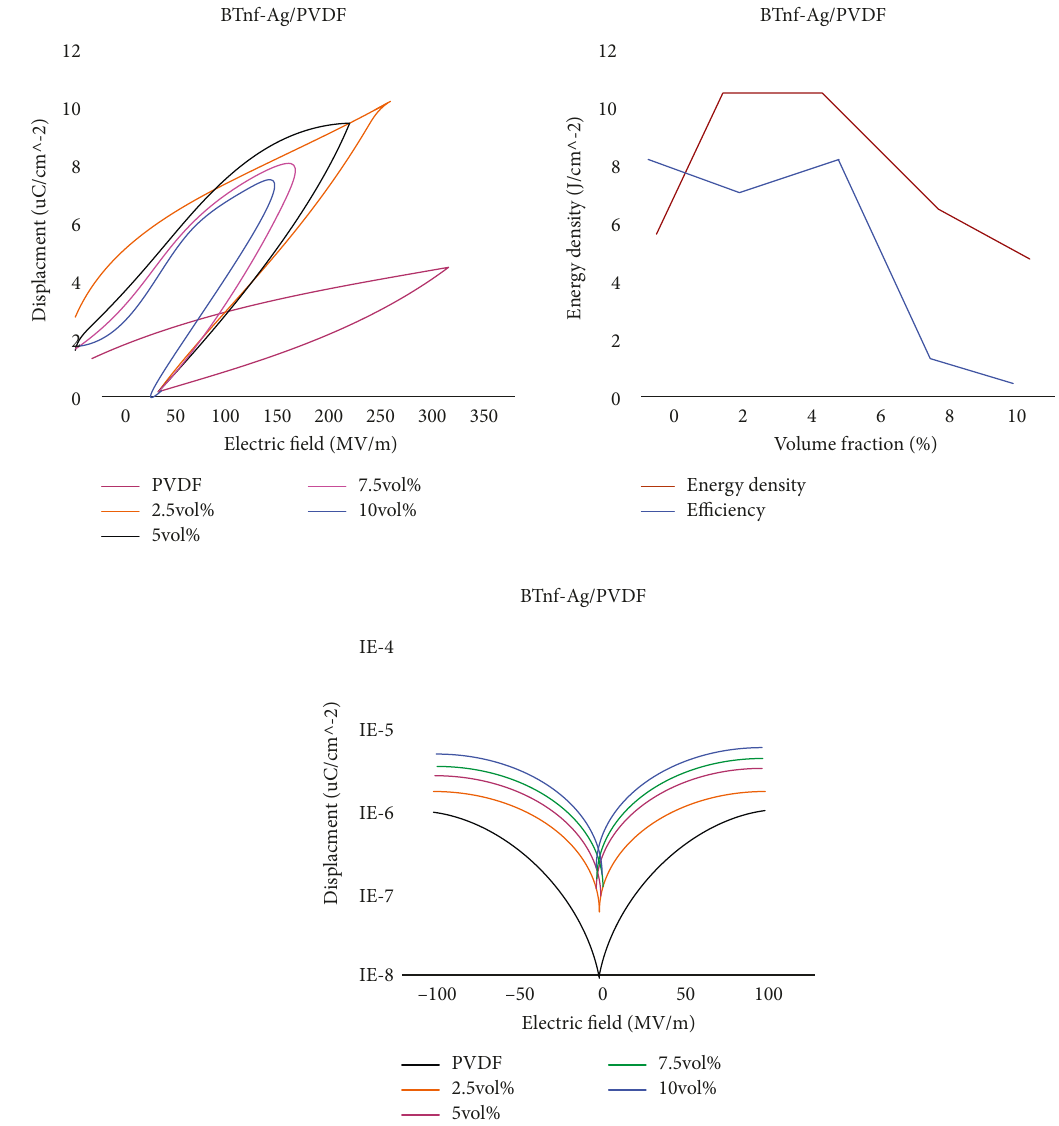
Figure 8: Hysteresis loop, energy storage density, and leakage current of the BTnf-Ag/PVDF composite